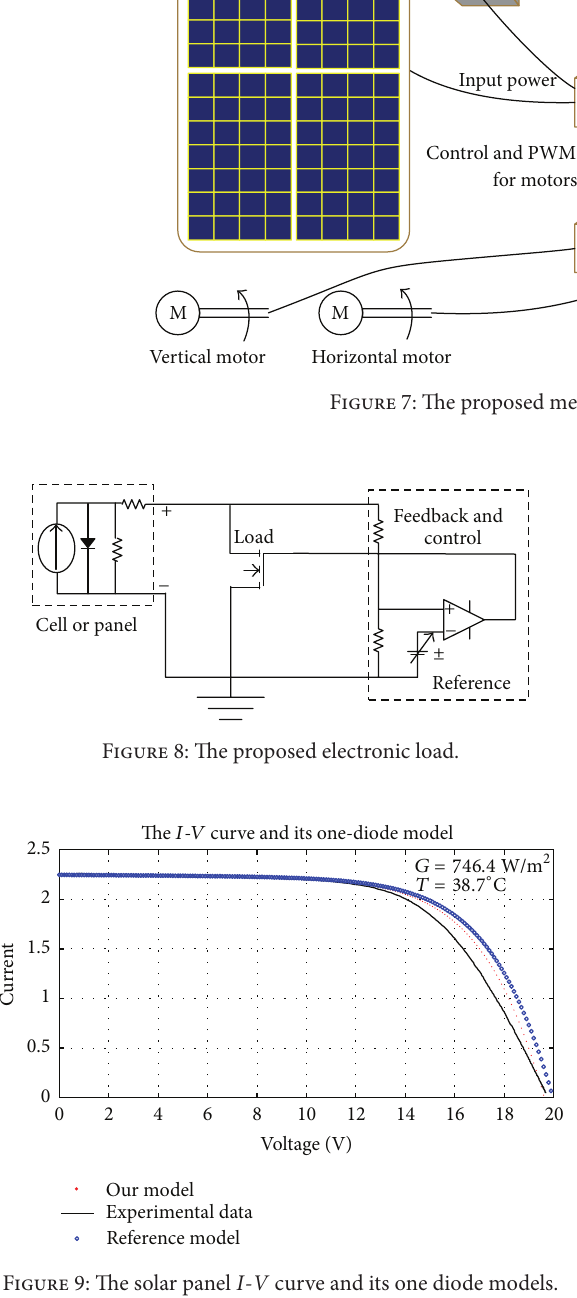
Figure 9: The solar panel I - V curve and its one diode models.